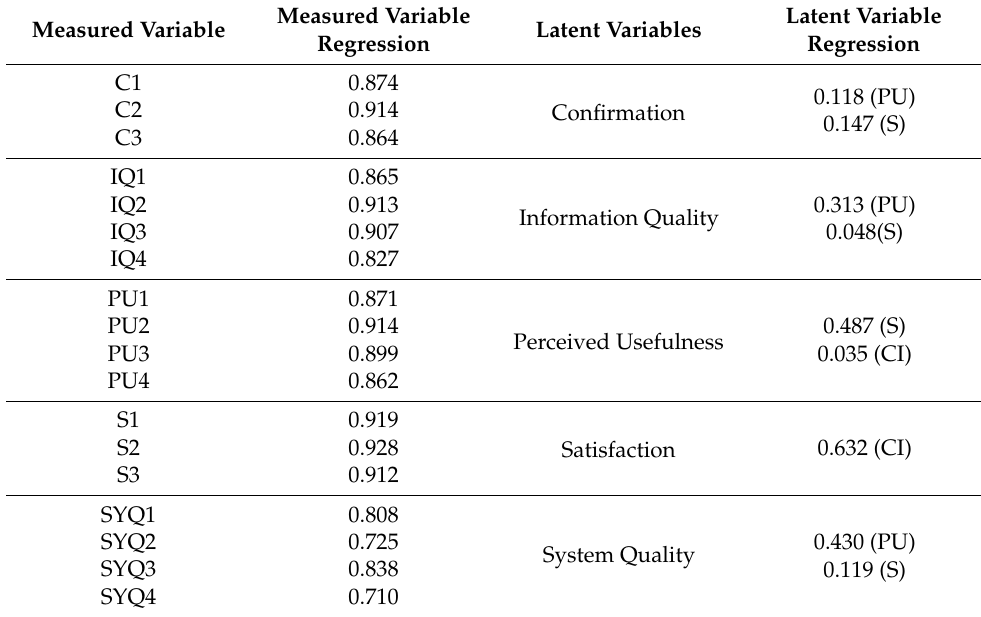
Table 4. Regression Value Comparisons among